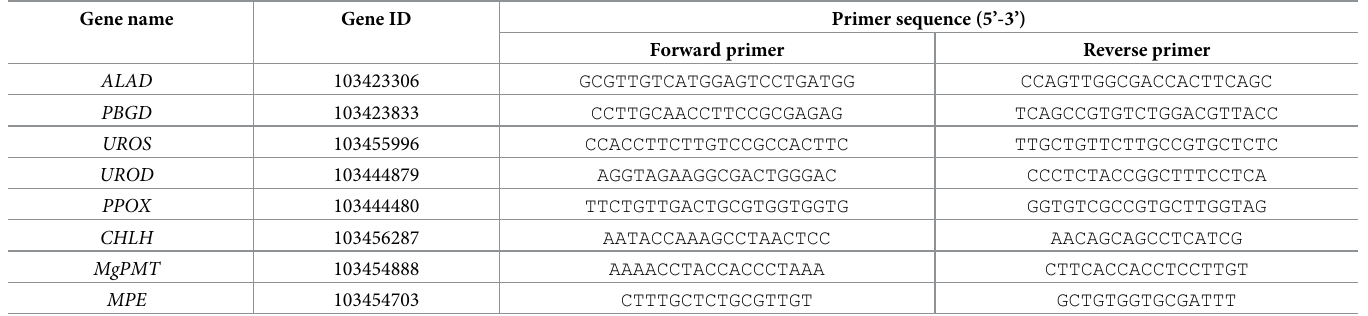
Table 1. Primers used for